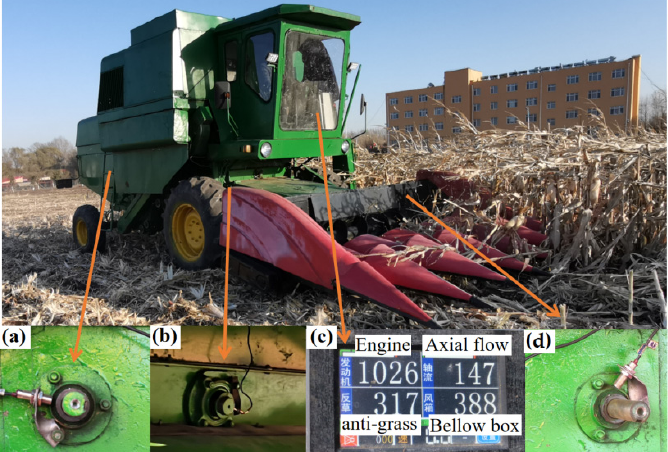
Figure 2. Harvester speed detection: ( a ) detection of the re-detachment speed; ( b ) upper kernel speed; ( c ) speed indicator; ( d ) detection of cylinder speed.